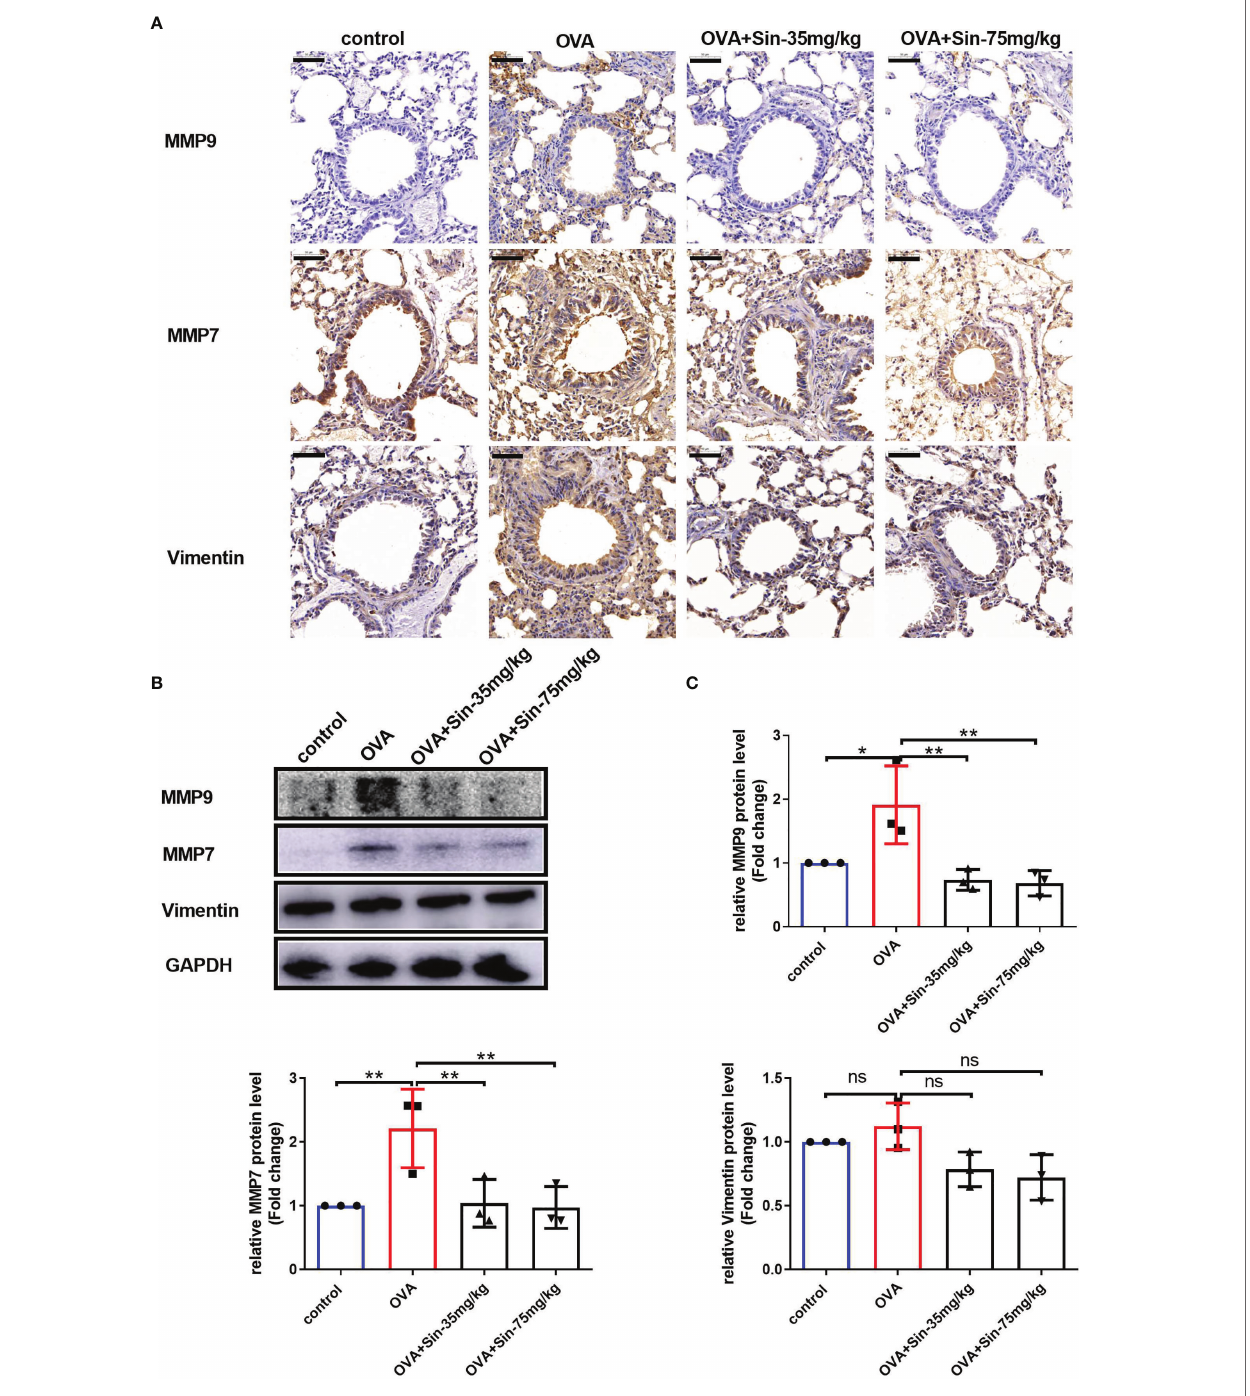
FIGURE 5 | Sin reduced the EMT of the airway epithelial cells in the lungs of the mice with OVA-induced asthma. (A) The protein levels of MMP9, MMP7, and vimentin were detected via immunohistochemistry. Scale bar indicates 50 m m. (B) The expressions of each protein were determined using Western blotting. (C) Statistical analysis of the gray values of each band normalized to GAPDH. The data are presented as mean ± SEM from three independent experiments. The one-way analysis of variance followed by Dunnett ’ s Multiple Comparison Test was used. *p < 0.05. **p < 0.01. ns, no signi fi cant difference between the two